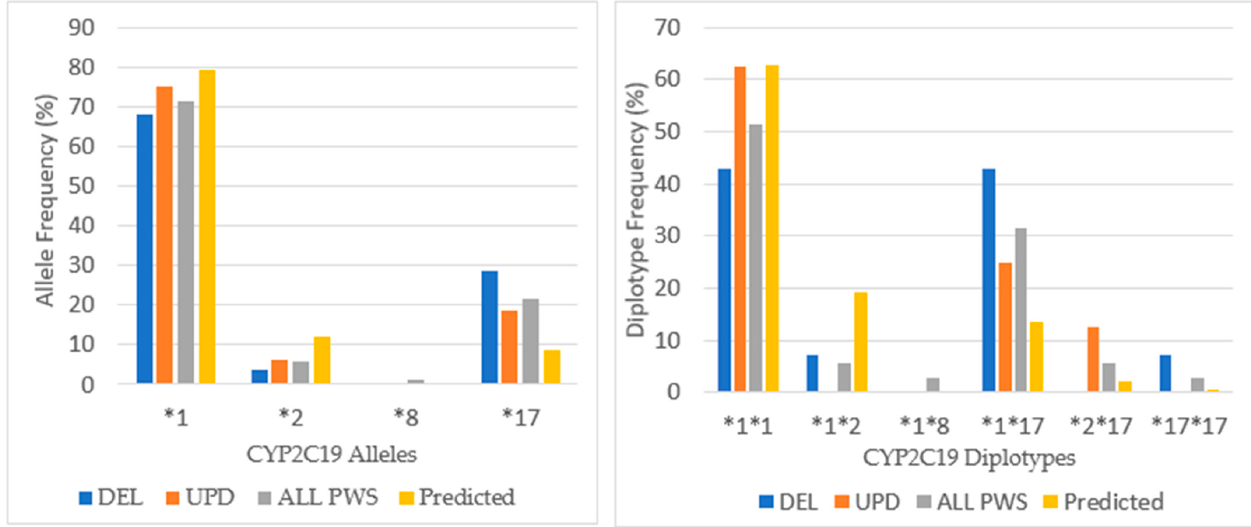
Figure 8. CYP2C19 allele frequency and distribution of diplotypes in PWS DEL ( n = 14), UPD ( n = 16) and combined cohort (ALL PWS, n = 35) compared to the predicted normative American data [http://www.pharmgkb.org/page/cyp2c19Ref- Materials].